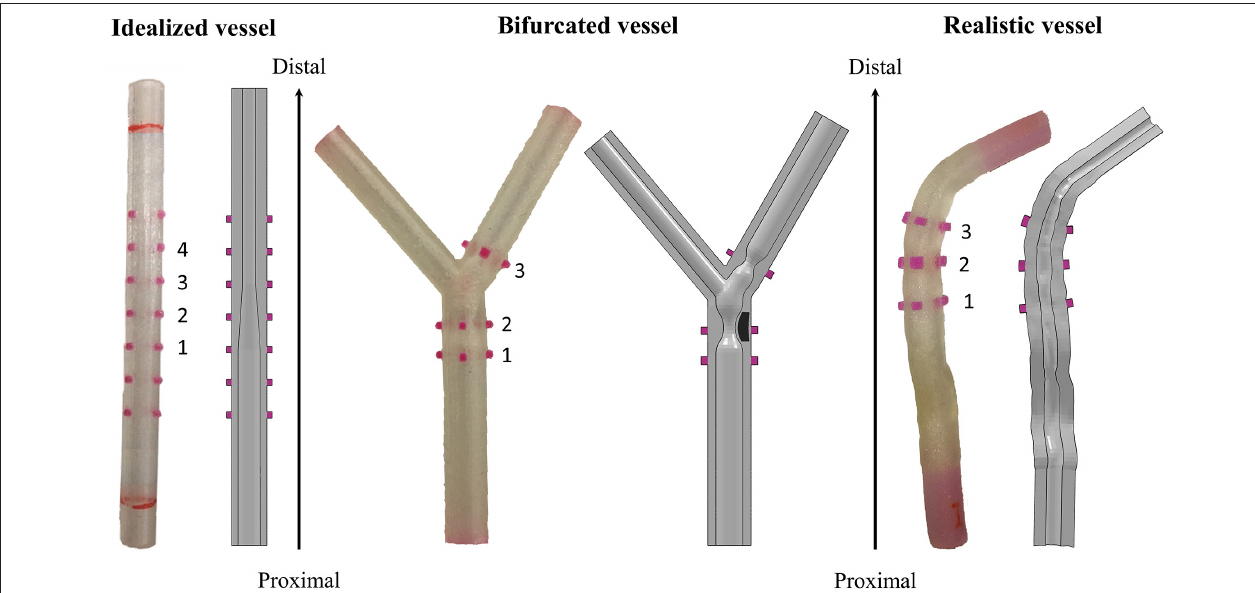
FIGURE 3 | Different designs of the 3D-printed mock vessels with an indication of the markers ID for the comparison between experiments and simulations. Each of the realistic phantoms is reported on the left of the corresponding CAD, which is shown as a section to highlight the morphology of the lumen.